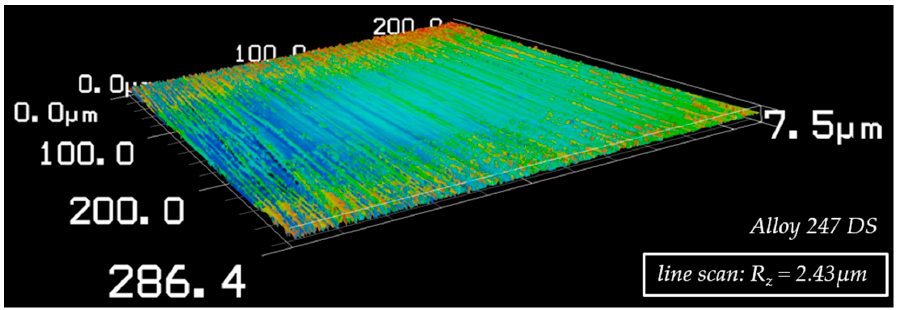
Figure 3. Microscopic structure of the finished sample surface (here Alloy 247 DS), captured via laser scanning microscope.